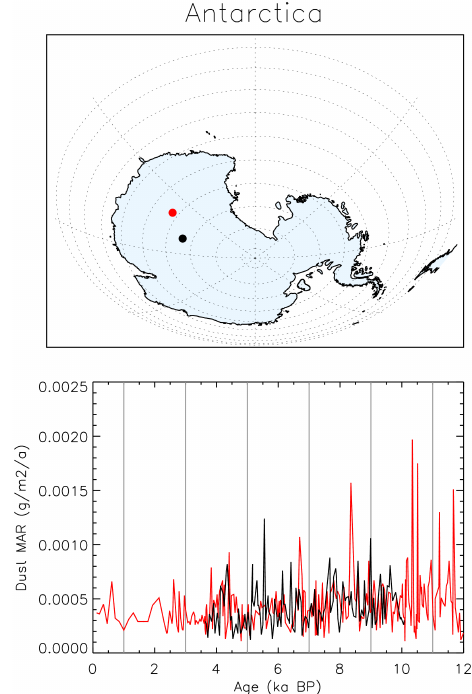
Figure 15. Same as Fig. 6 but for